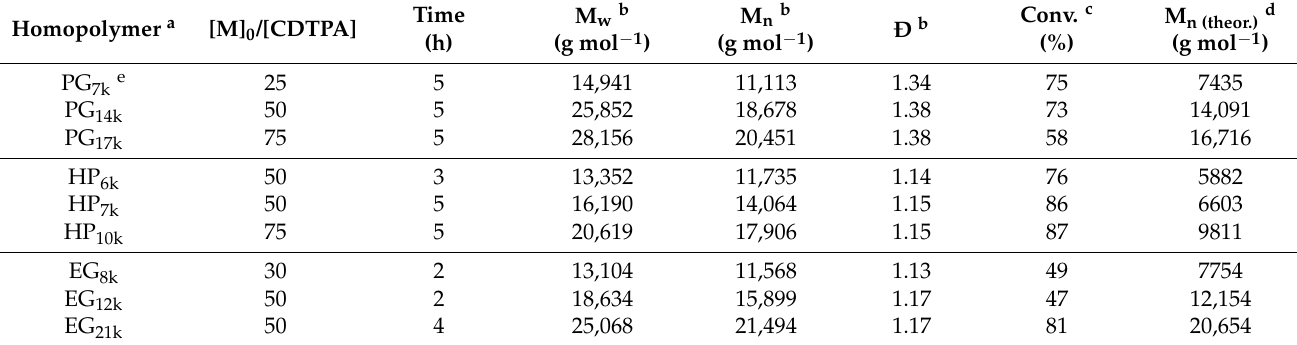
Table 1. Summary of reaction conditions for PG, HP homopolymers, EG macro-CTAs homopolymers, and EG-PG and EG-HP block copolymers synthesis; molecular weight parameters and conversion